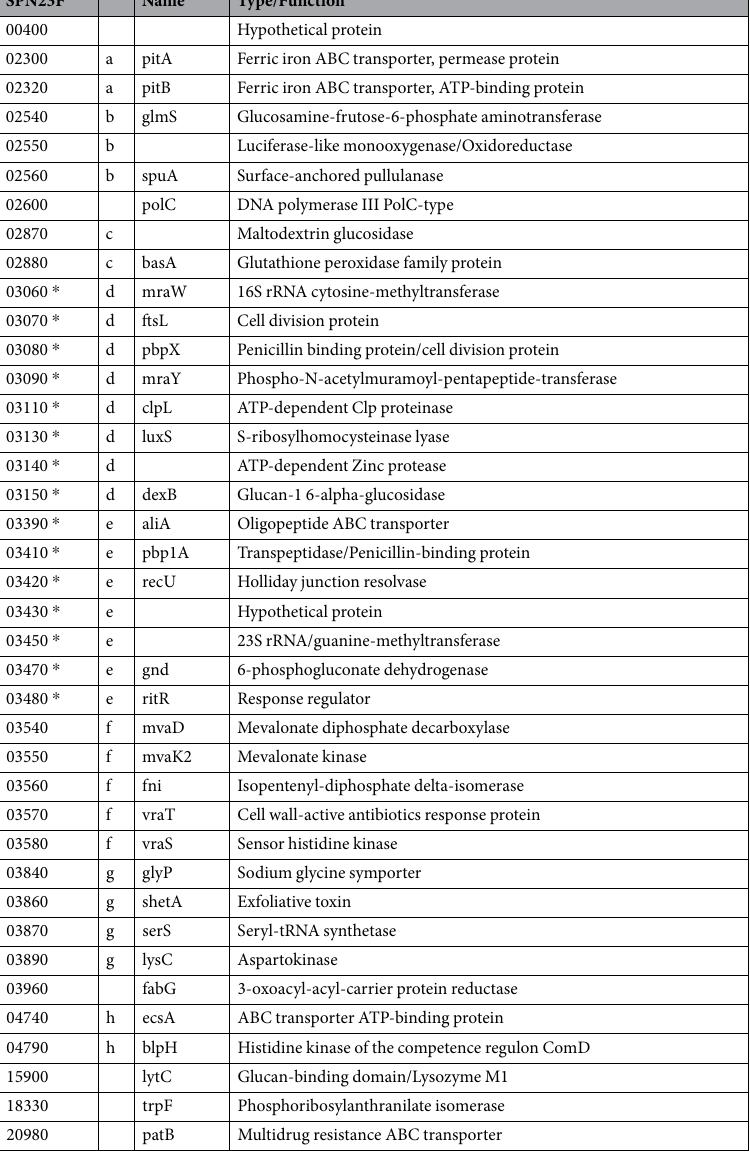
Table 1. Top genes for Serotype prediction. Genes marked with * flank up to 10 genes, upstream or downstream from the capsular locus. Letters a to h denote groups of contiguous genes (minimum proximity of 2